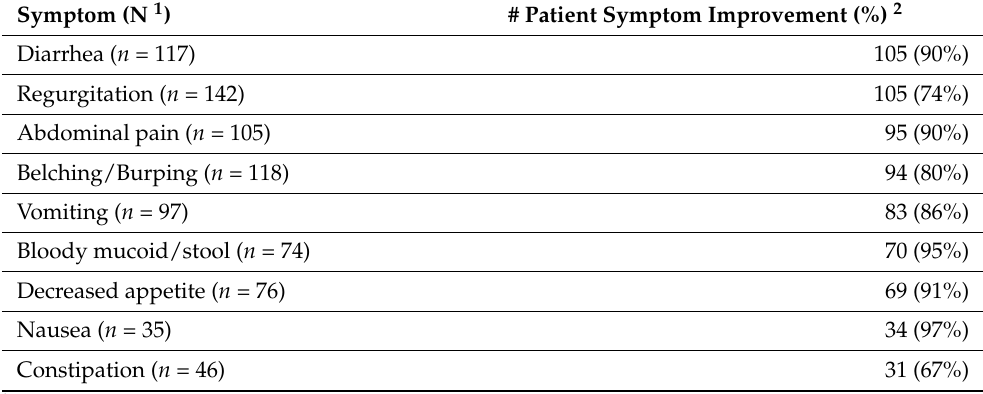
Figure 2. Percentage of infants with a recorded variable symptom at Visit 1 in the eHF population ( n = 202). Table 2. Distribution of GI symptoms in infants ≤ 6 months of age with diagnosed or sus- pected